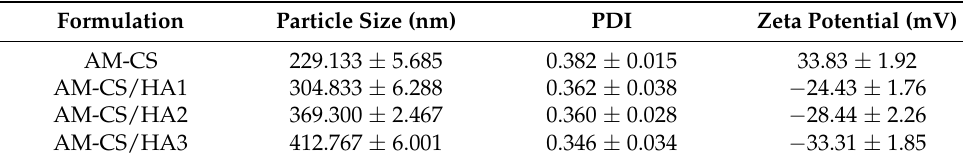
Table 2. Particle size, distribution, and zeta potential of AM nanoparticles.